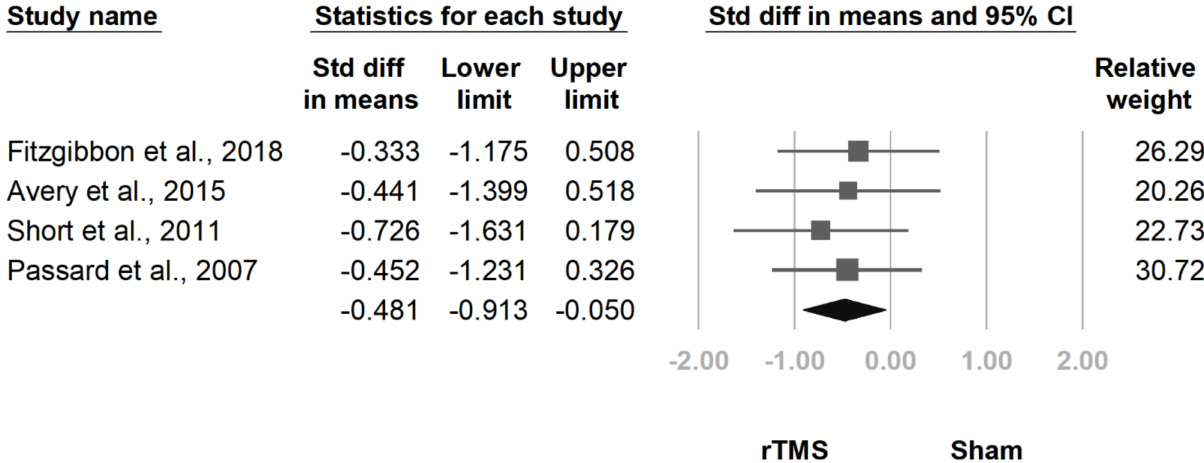
Figure 9. Forest plot of standardized mean differences in the interference subscale of the Brief Pain Inventory after treatment. Squares indicate effect sizes of individual studies, lines indicate 95% CI, and diamond indicates the summarized effect size.